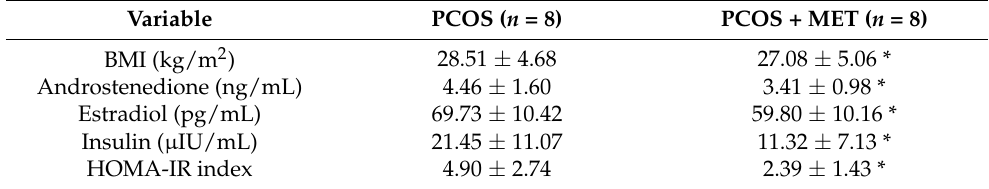
Table 2. Hormonal and metabolic variables improved in PCOS patients after metabolic intervention.